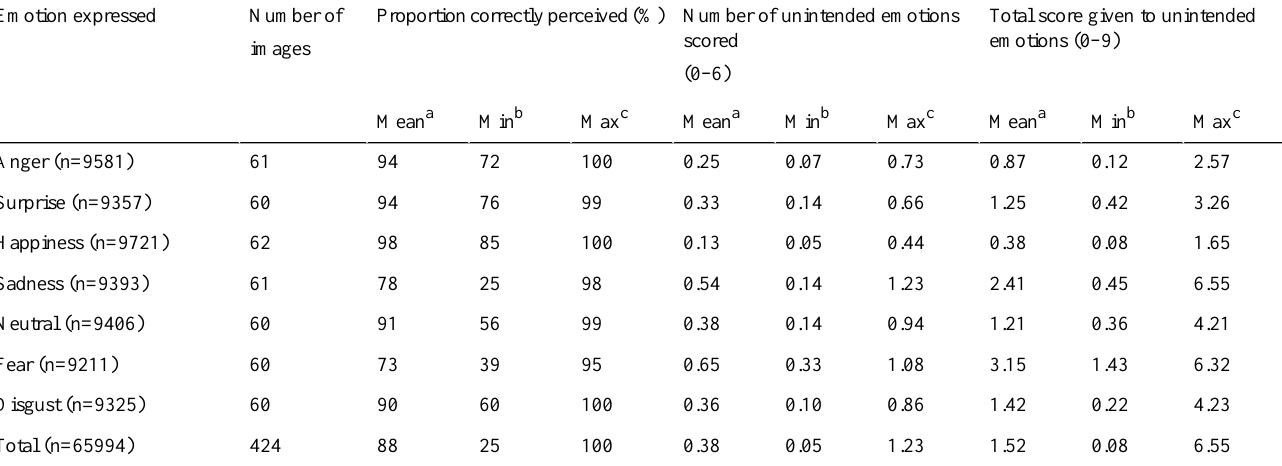
Table 1. Summary of the proportion of images correctly perceived, number of unintended emotions scored and the total scores given to unintended emotions.